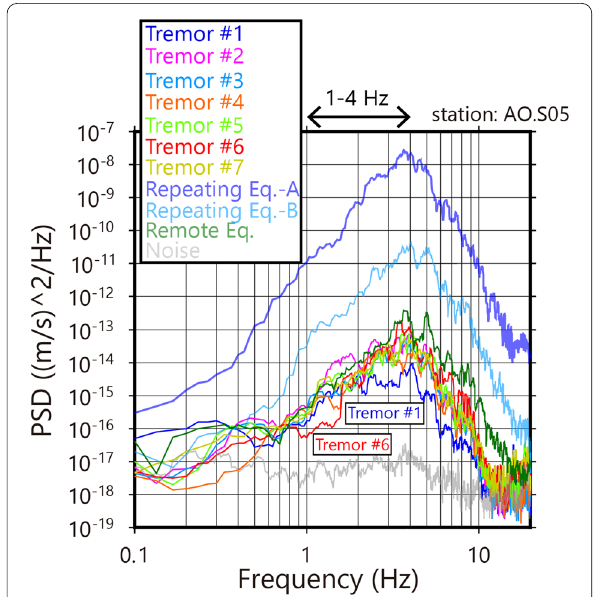
Fig. 5 Power spectral density of tremor #1–7, repeating earthquake-A and -B, remote earthquake, and background noise in horizontal components. Known very low-frequency earthquake (VLFE) #1 has lower power than those of the other tremors in all frequency bands. VLFE #6 lacks power in a frequency range of 1–2